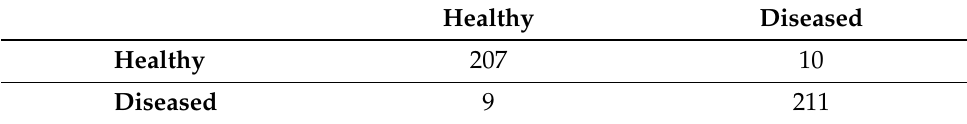
Table 7. Confusion Matrix for the test data—CNN